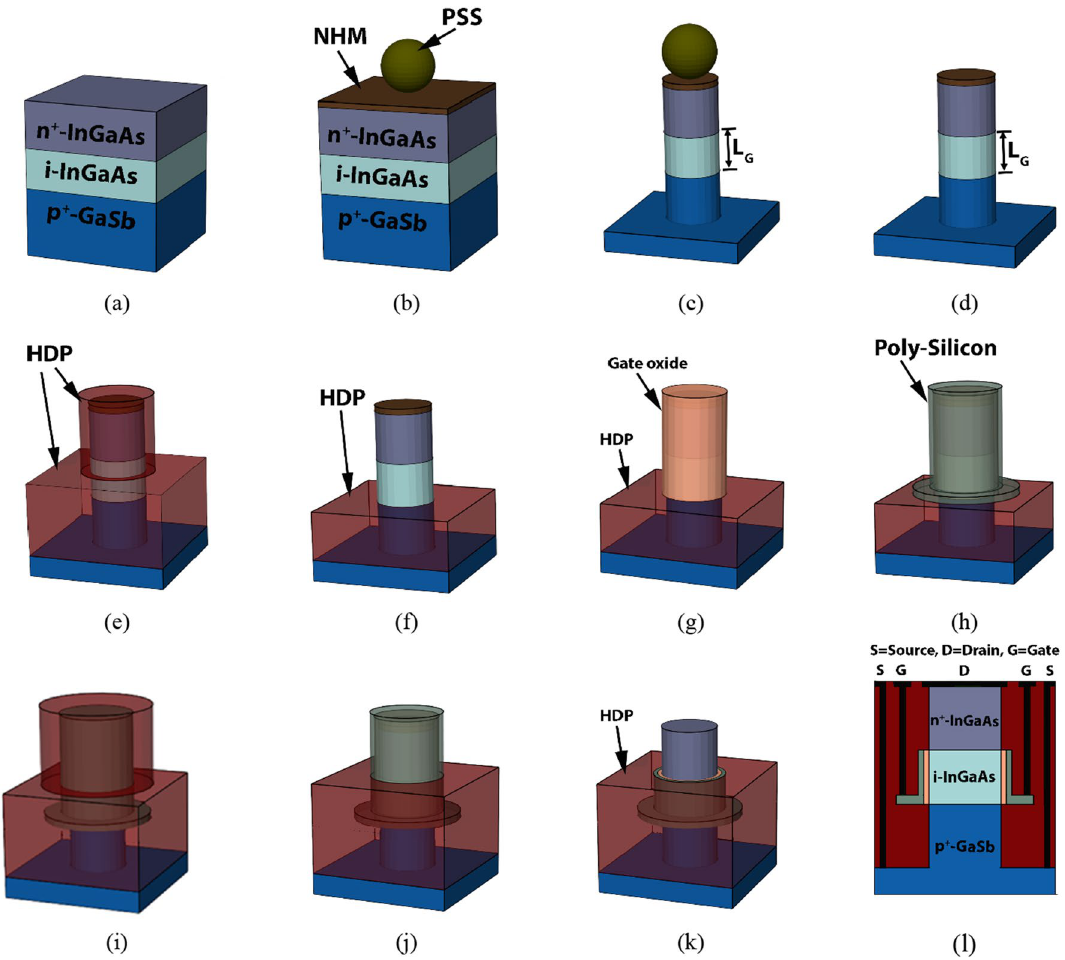
Figure 3. Schematic of III–V eGAA TFET fabrication steps: ( a ) III–V material deposition, ( b ) PSS placement, ( c ) RIE on PSS to get 20 nm sphere followed by NHM deposition, ( d ) deep RIE etching process, ( e ) PSS of 20 nm diameter and NHM etched away, ( f ) SiO 2 deposition, ( g ) PSS of 24 nm diameter and NHM deposition, ( h ) DHF etch-back up to the source-channel junction, ( i ) PolySilicon deposition, ( j ) SiO 2 deposition, ( k ) contact tip implantation followed by contact